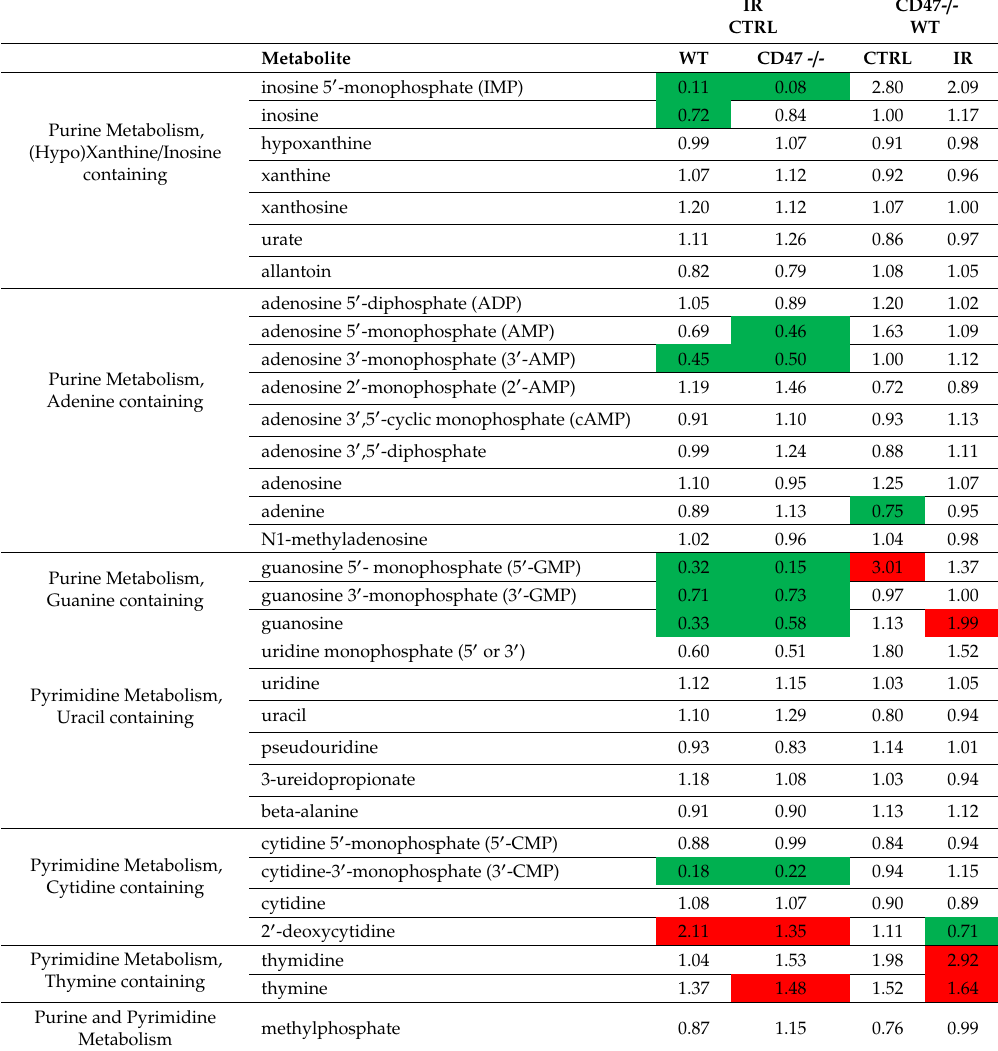
Table 3. Regulation of nucleotide metabolism